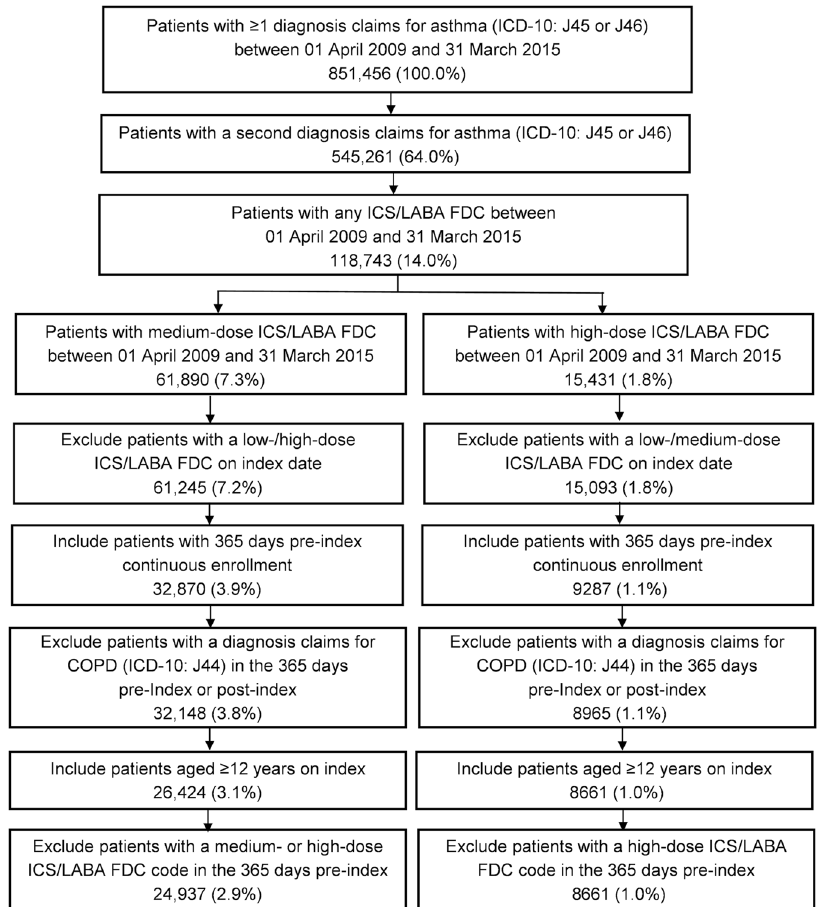
Fig. 1 Patient disposition according to JGL 4 . COPD chronic obstructive pulmonary disease, FDC fi xed-dose combination, ICS inhaled corticosteroid, JGL Japanese asthma guidelines, LABA long-acting β 2